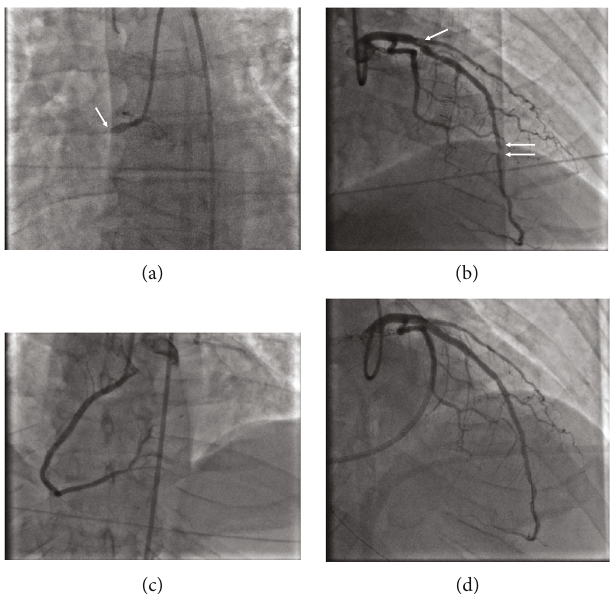
Figure 1: (a) Diagnostic arteriogram demonstrating acute complete thrombotic occlusion in the proximal right coronary artery (arrow) representing the culprit lesion and (b) 90% stenosis in the proximal left anterior descending (LAD) coronary artery (arrow) and 95% stenosis in the mid LAD (double arrow). (c) Coronary arteriogram post-percutaneous coronary intervention (PCI) of the RCA with placement of drug eluting stents with restoration of coronary blood fl ow. (d) Coronary arteriogram post-PCI of the proximal and mid LAD with placement of drug eluting